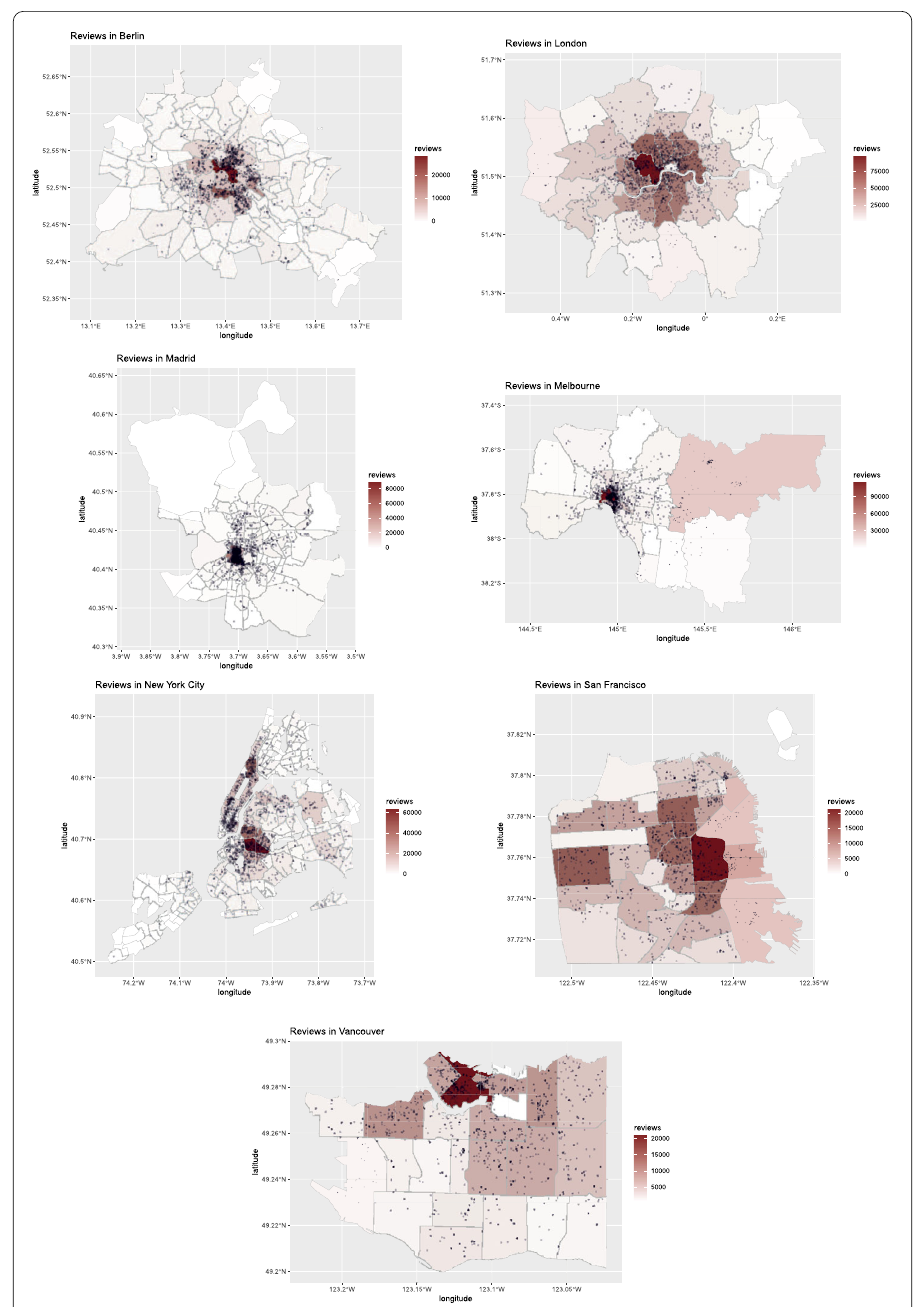
Figure 19 Demand (guest) density in the seven Western cities analysed